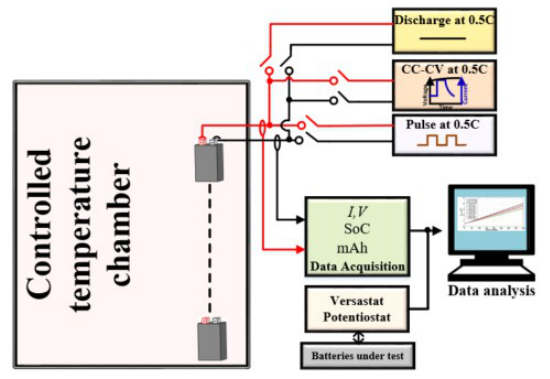
Figure 8. Experimental setup for determining impact of charge algorithms on battery.